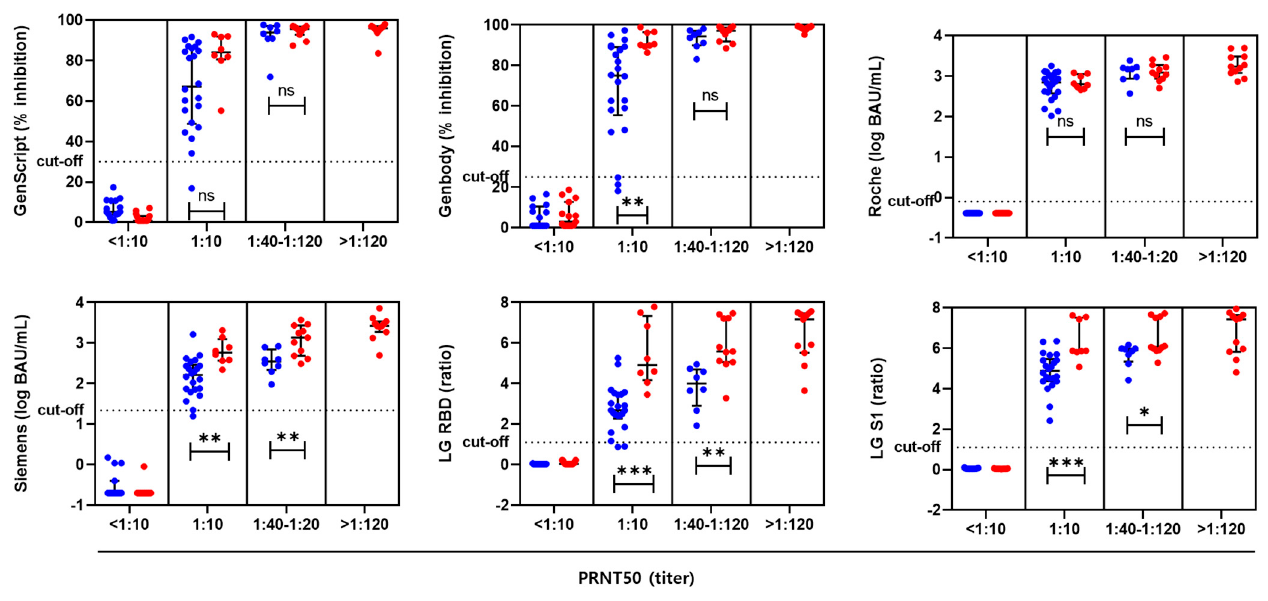
Figure 2. Levels of SARS-CoV-2 antibodies determined by six serological assays according to PRNT 50 results. AZ vaccine group (blue dots) and BNT vaccine group (red dots) are indicated.